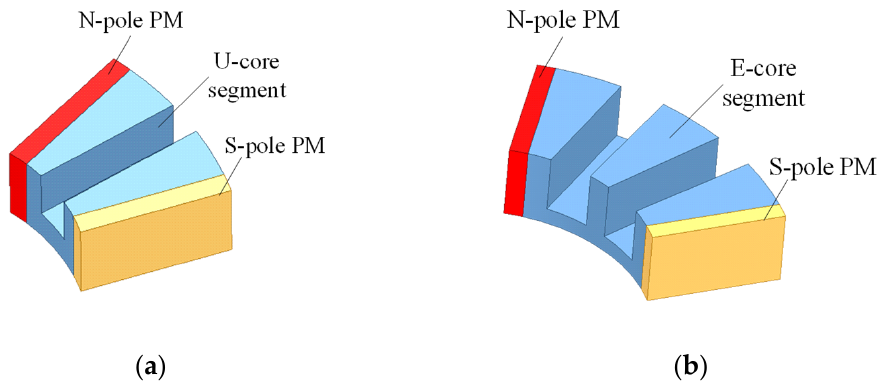
Figure 2. Configuration of two different modular stator segments. ( a ) U-core stator segments and PMs; ( b ) E-core stator segments and